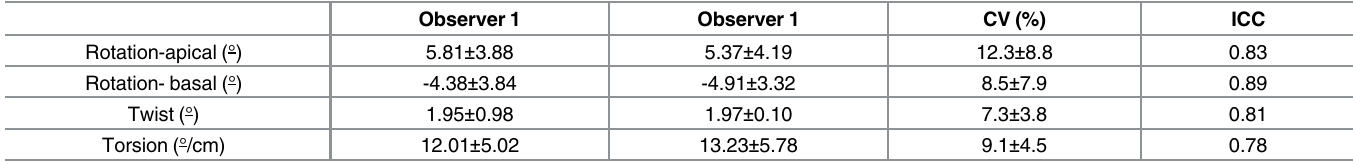
Table 6. Intra-observer variability of LV twist, torsion and rotation by